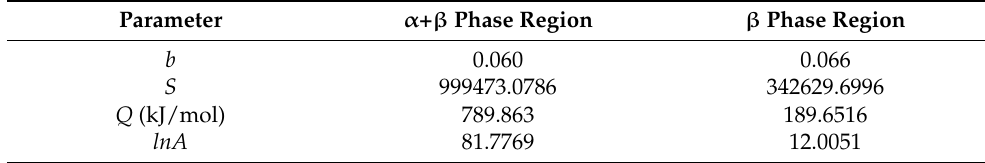
Table 3. Parameter values of exponential equation at strain